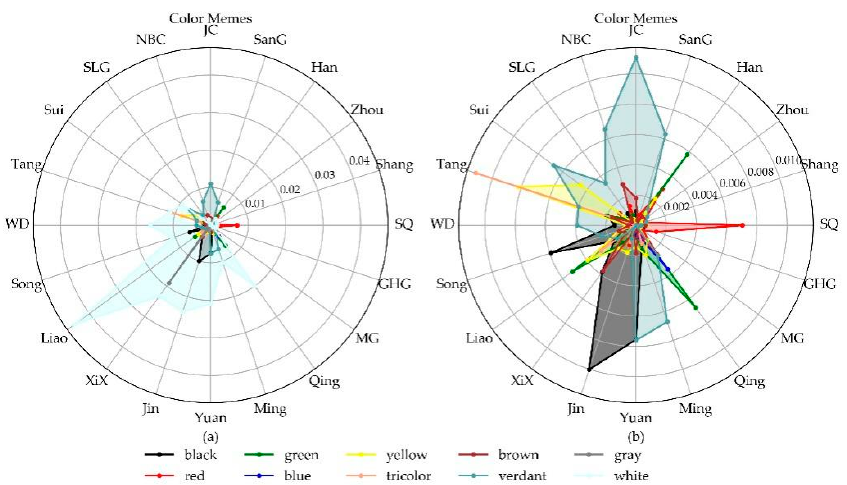
Figure 2. Color meme distribution trend. ( a ) Shows the temporal distribution of the ten color memes, and ( b ) Shows the temporal distribution of the two colors after removing gray and white.